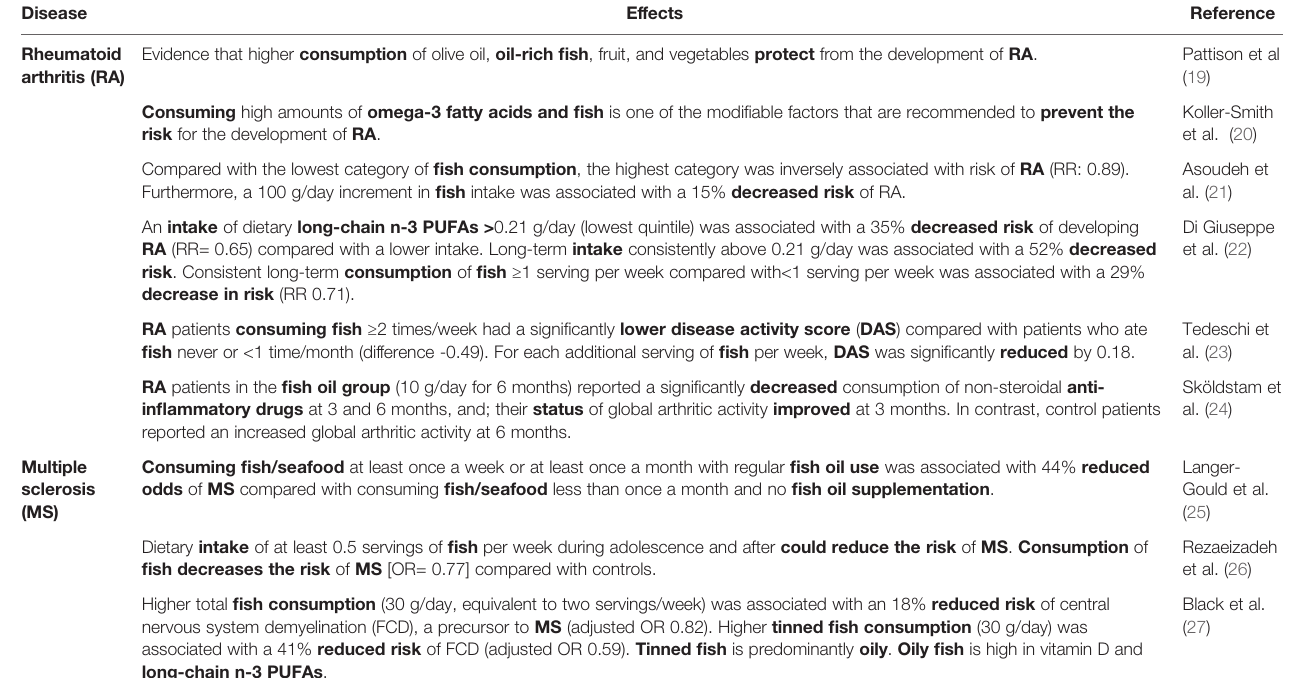
TABLE 2 | Example literature on the effects of fi sh/ fi sh oil consumption or supplements containing omega-3 polyunsaturated fatty acids (PUFA) on representative autoimmune diseases. *